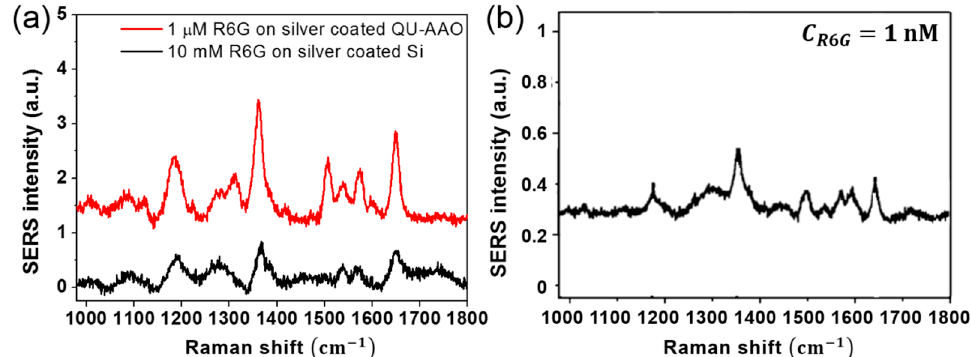
Figure 10. SERS spectra for enhancement calculation and detection limit. ( a ) SERS spectra of R6G on Ag coated QU ‐ AAO (the red solid line, C R6G = 1 μ M) and on Ag coated Si (the black solid line, C R6G = 10 mM). From the three main peaks in the Raman spectrum (1185, 1365, and 1650 cm − 1 ), we obtained a SERS enhancement factor of ~0.2 × 10 5 . The fabrication conditions for the HU ‐ AAO are an anodization time of 30 s, a pore widening time of 0 min, and the deposition of a 20 nm Ag layer; ( b ) SERS spectrum for 1 nM R6G on Ag coated QU ‐ AAO.